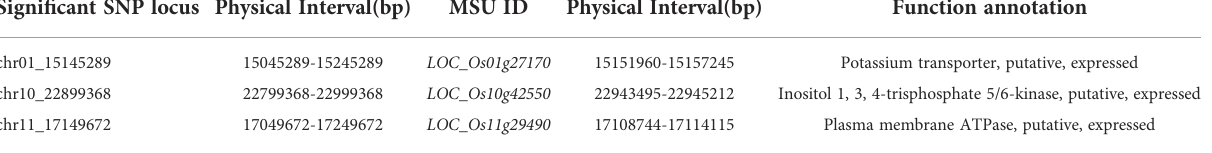
TABLE 3 Candidate genes related to salt stress at the germination stage.